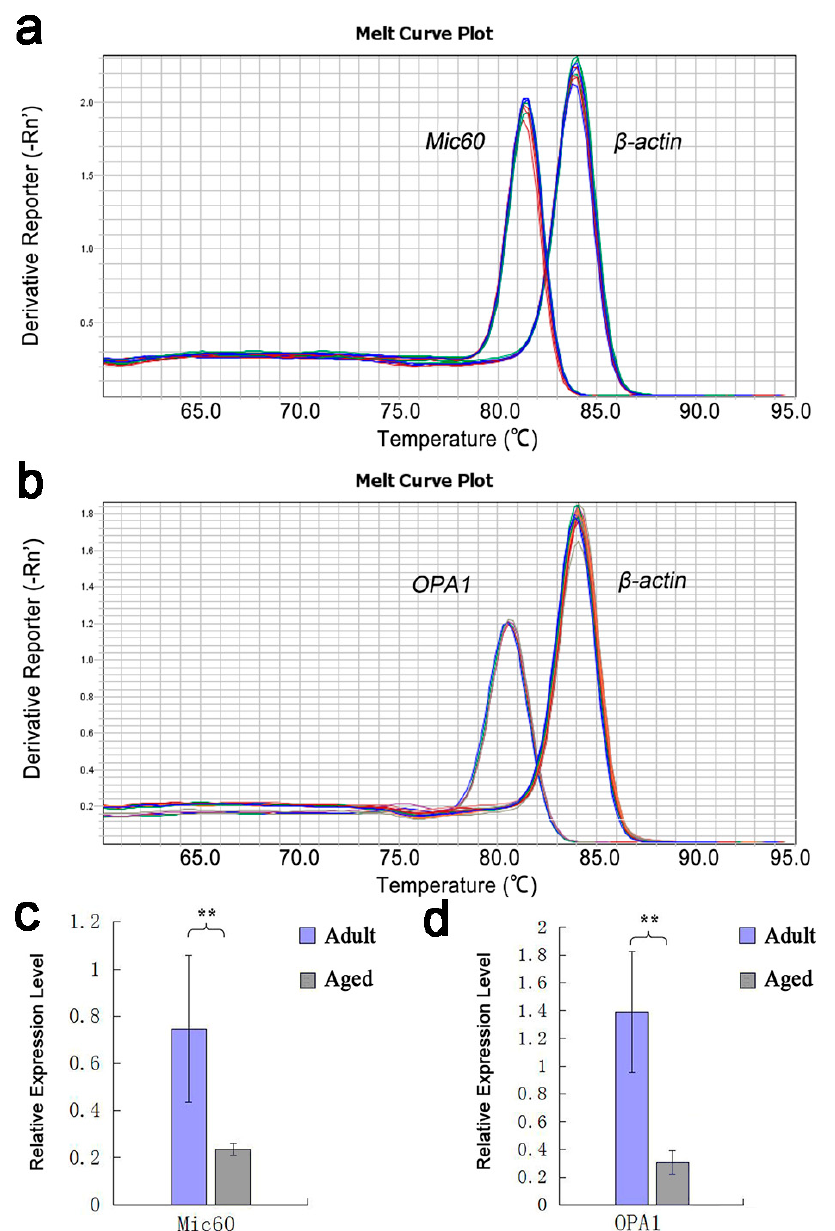
Figure 1. Melting curves of Mic60 , OPA1 and β -actin genes and their relative expression in adult and aged Tibetan sheep cardiomyocytes. Note: ( a , b ): Melting curve of Mic60 , OPA1 and β -actin genes. ( c , d ): Relative expression of Mic60 and OPA1 genes. All data showed as means ± SD ( n = 3). ** p < 0.01.